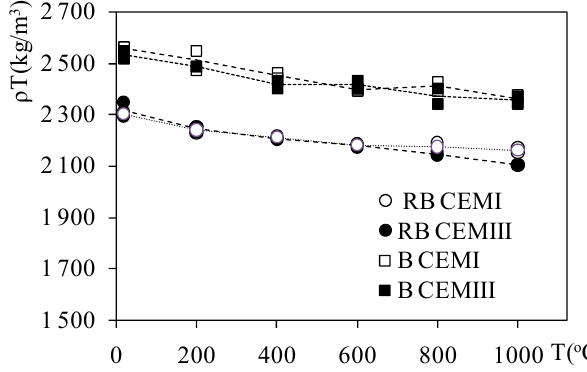
Figure 2. Bulk density of riverbed aggregates (RB) and basalt (B) concretes made with CEMI and CEMIII concretes; mean value of three samples.